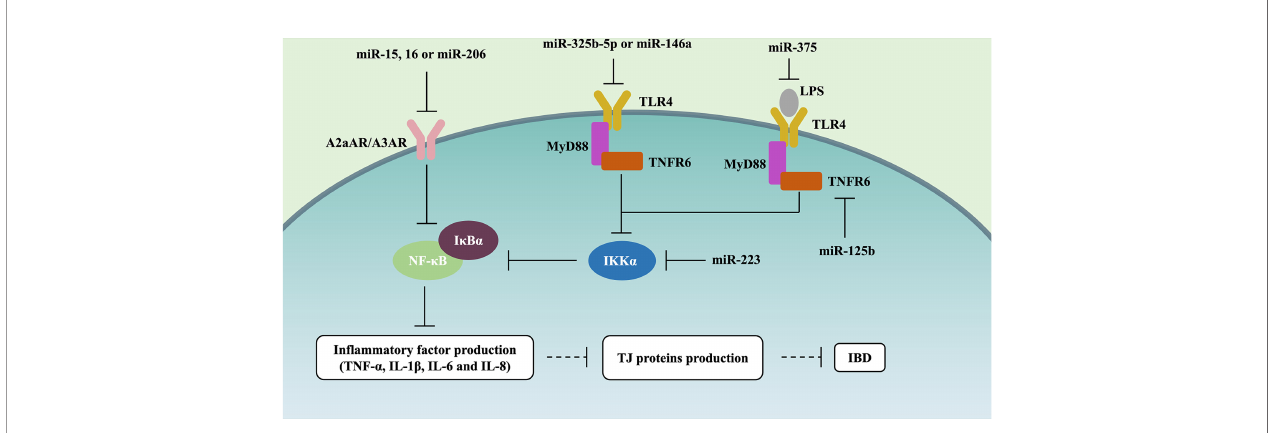
FIGURE 2 | miRNAs control NF- k B signaling pathway in IBD. miR-15, miR-16, and miR-206 downregulate A2aAR or A3AR expression, further inhibiting NF- k B and the level of IL-8 and IFN- g in UC. miR-323b-5p and miR-146a target and inhibit the TLR4/MyD88/NF- k B signaling pathway. miR-375 competitively inhibits TLR4 expression, further alleviating the generation of pro-in fl ammatory cytokines (TNF- a , IL-1 b , IL-6, and IL-8) and the deterioration of intestinal mucus (i.e., ZO-1 and occluding downregulation). miR-125b and miR-223 inhibit TLR4/MyD88/NF- k B signaling pathway through respectively downregulating TRAF6 and IKK a in